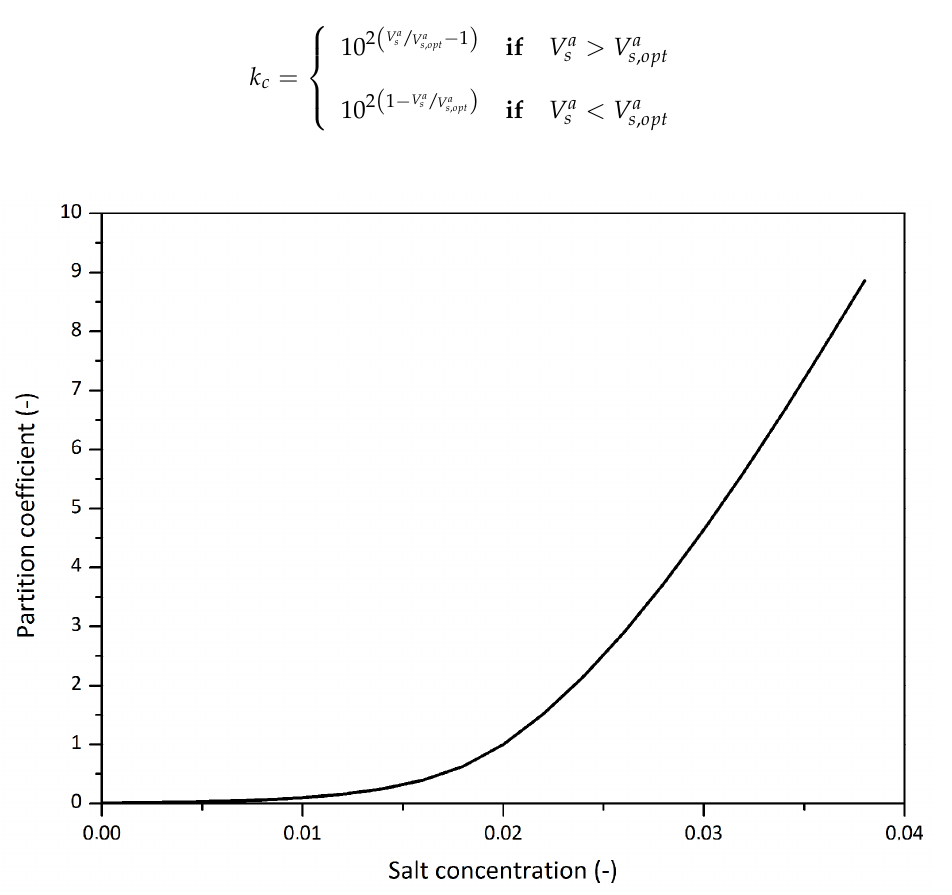
Figure 3. Partition coefficient dependence on the salinity. In this example, according to Equation (15), the optimum volumetric concentration of salt in water ( V a equal to